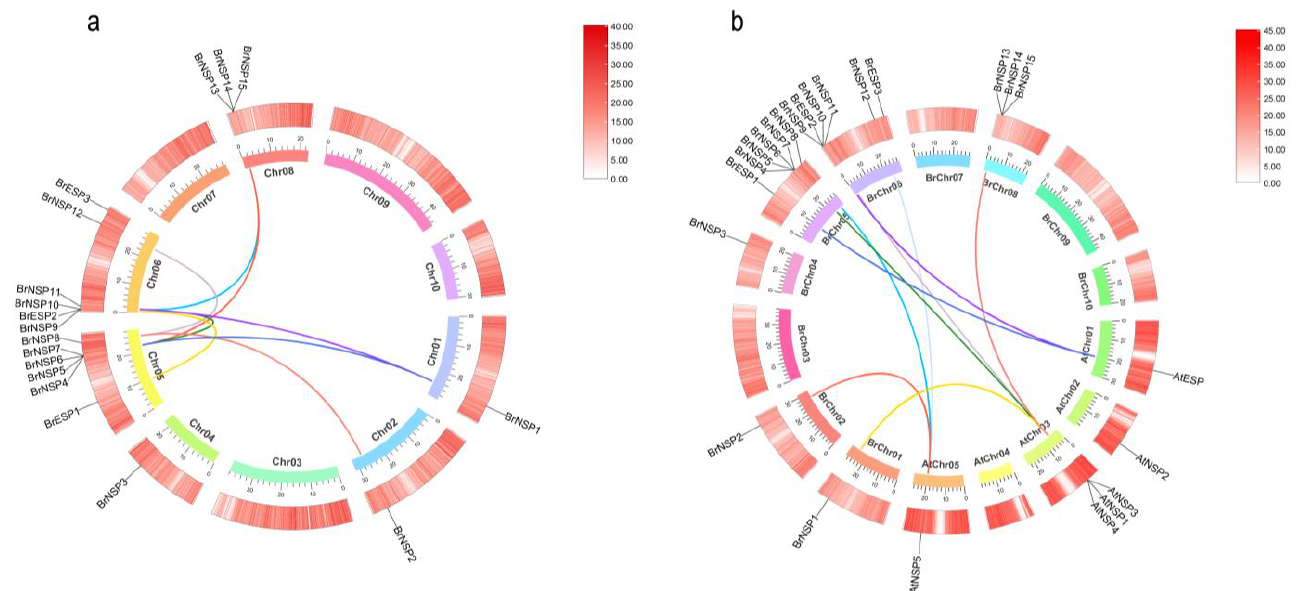
Figure 3. Schematic of the synteny relationships of ESP and NSP genes. ( a ) Evolutionary analysis of ESP and NSP genes in Chinese cabbage; ( b ) collinearity analysis of ESP and NSP genes between Arabidopsis thaliana and Chinese cabbage. The outermost circle shows the density of each chromosome, and the inner circle shows the chromosome number. The colored lines represent collinear ESP and NSP gene pairs. Table 2. Duplications of ESP and NSP genes in Chinese cabbage.